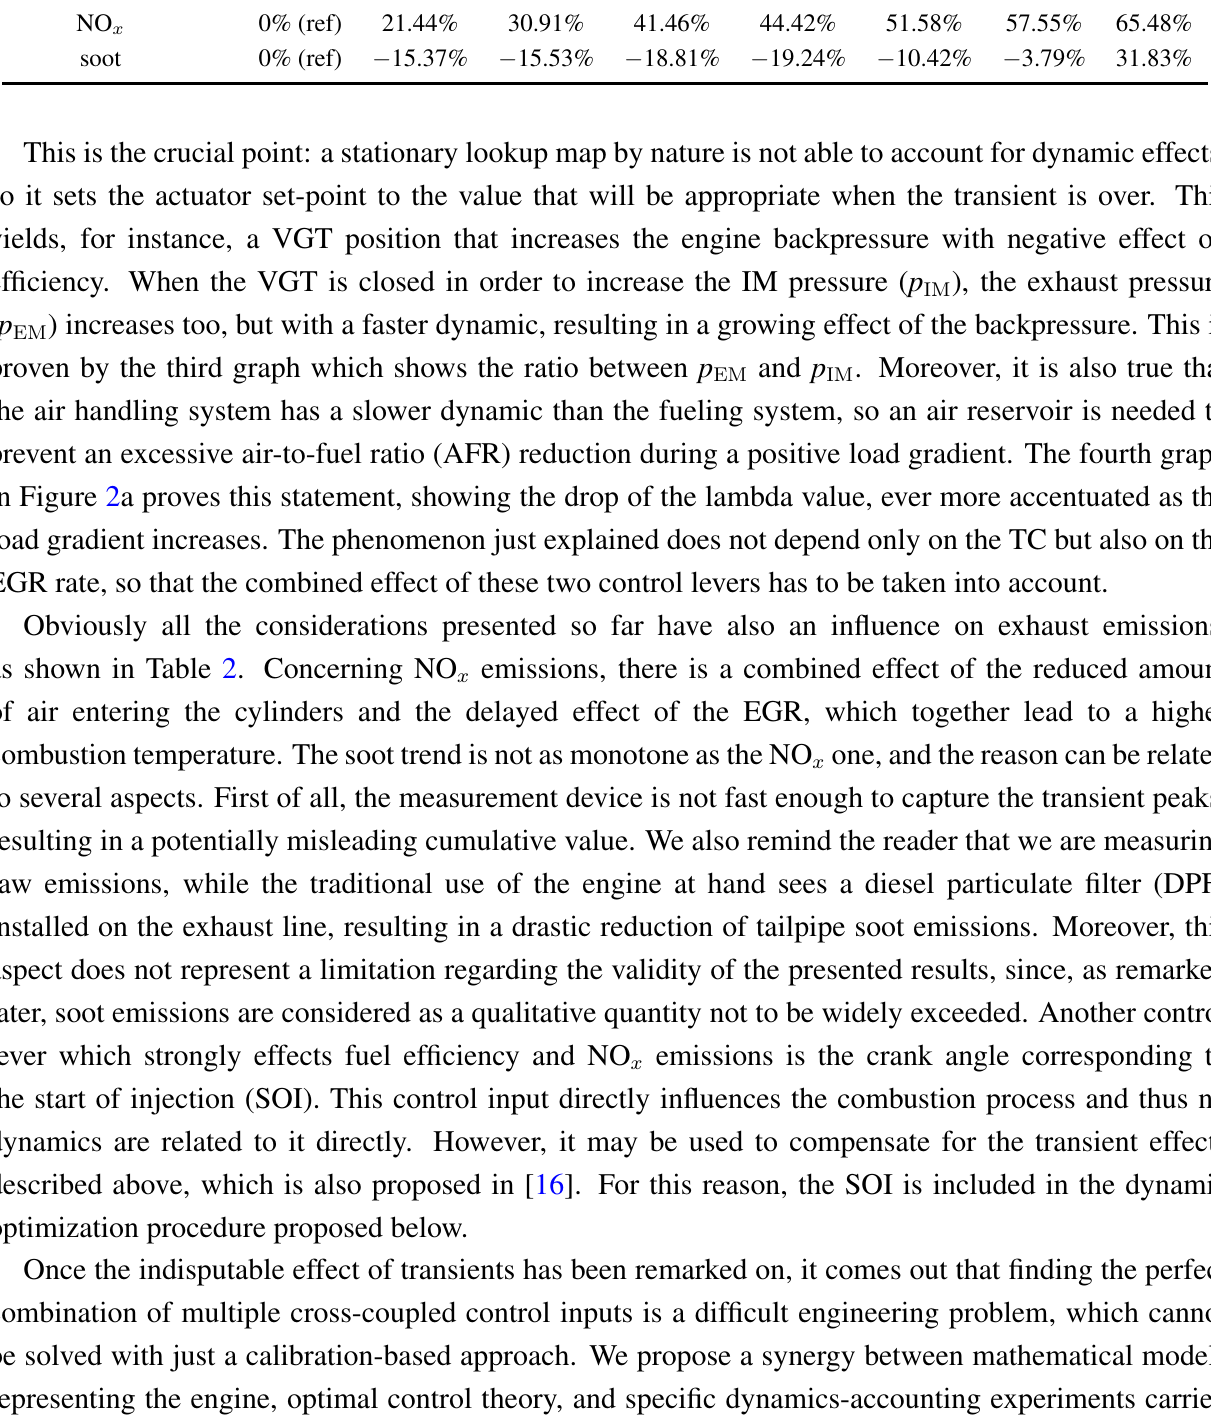
and soot related to the integrated x